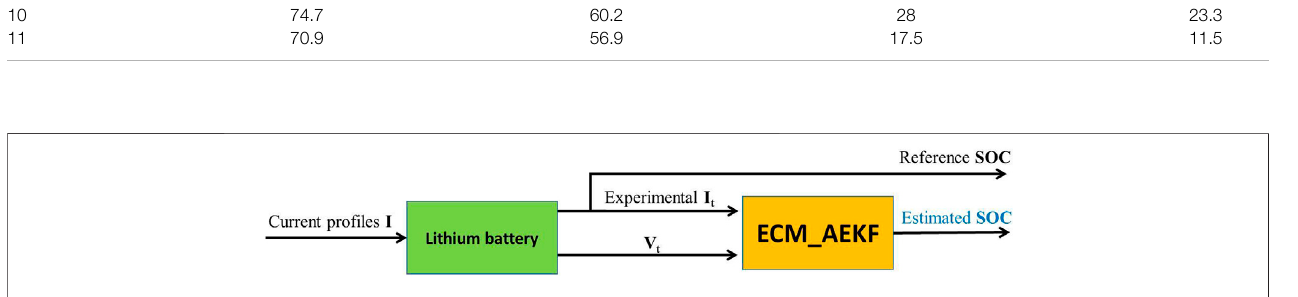
FIGURE 3 | SOC estimation strategy without sensors ’ noise